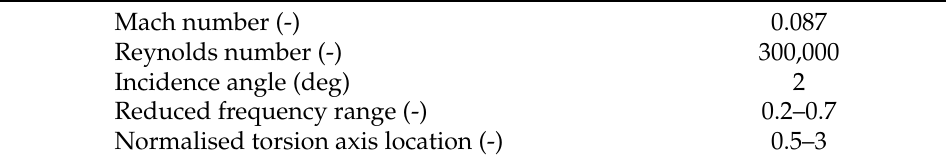
Table 1. Cascade operating